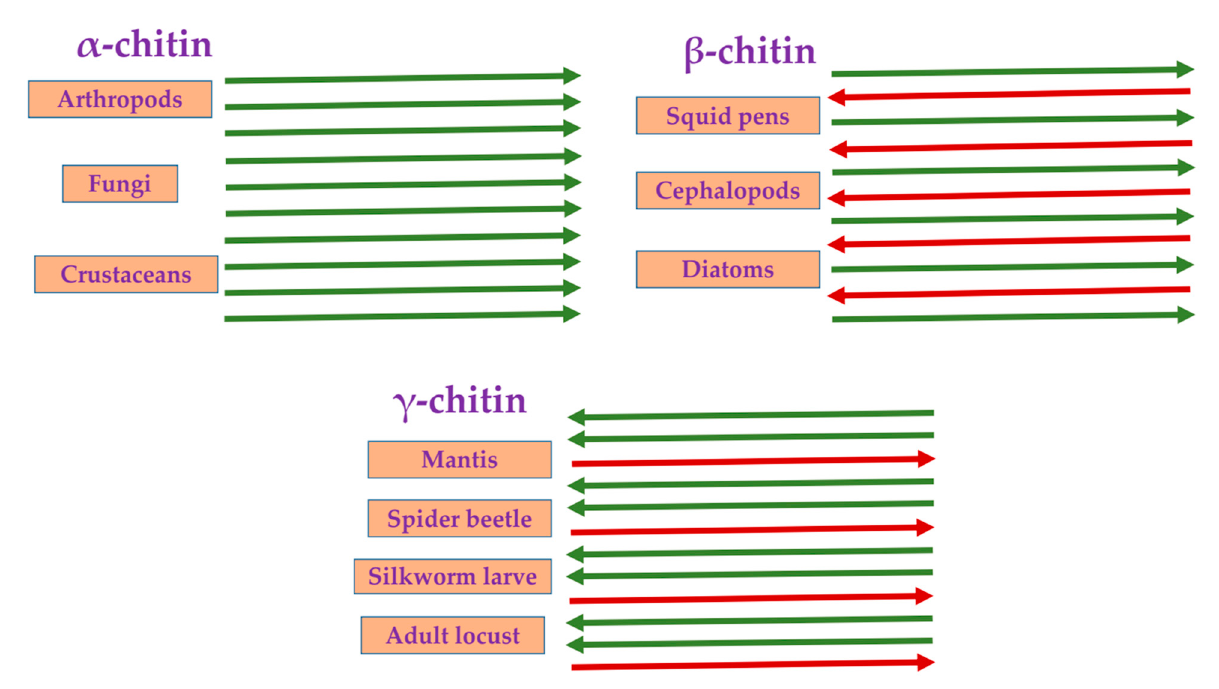
Figure 1. Schematic representation of the three polymorphs of chitin and their respective source